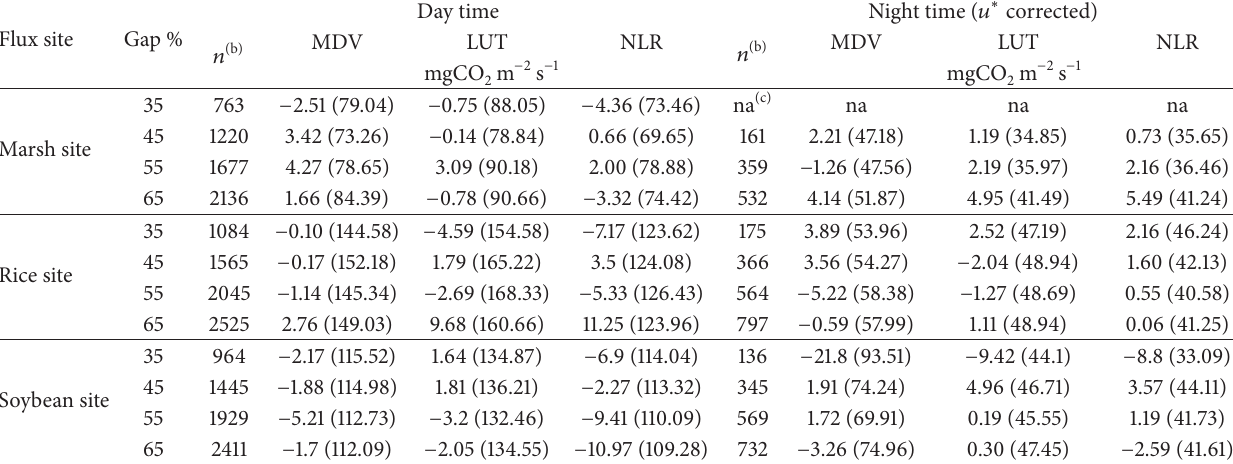
and standard deviation from the mean (a) NEE